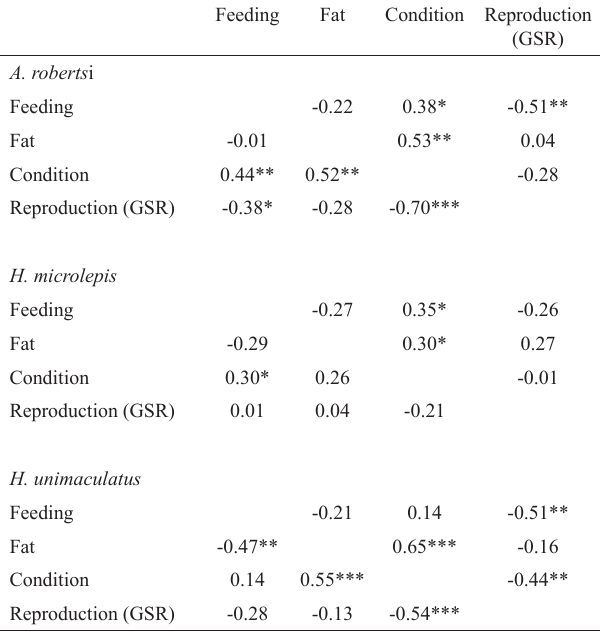
Table 3. Correlation (Spearman rank) among ecological traits measured in populations of A. robertsi , H. microlepis , and H. unimaculatus . Females = upper diagonal; Males: lower diagonal.